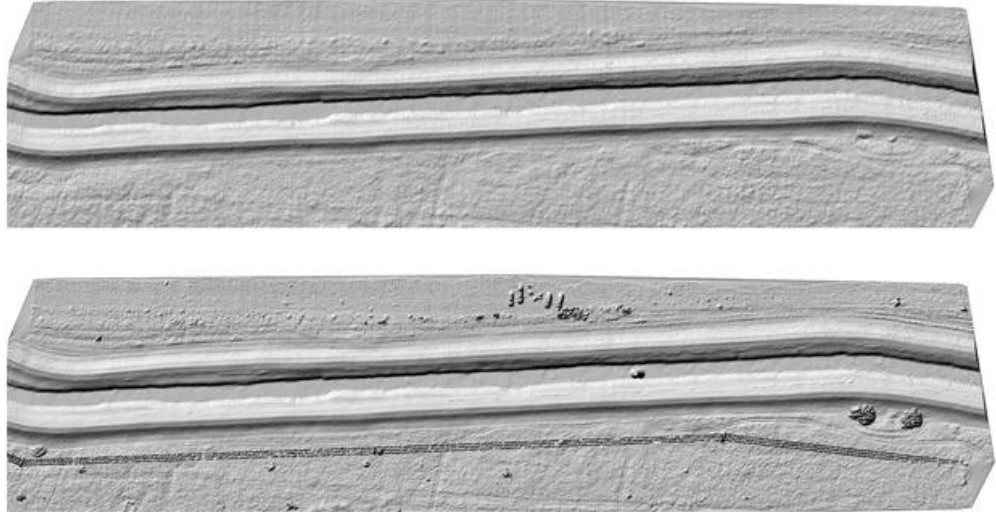
Figure 9. The Digital Terrain Model and the Digital Surface